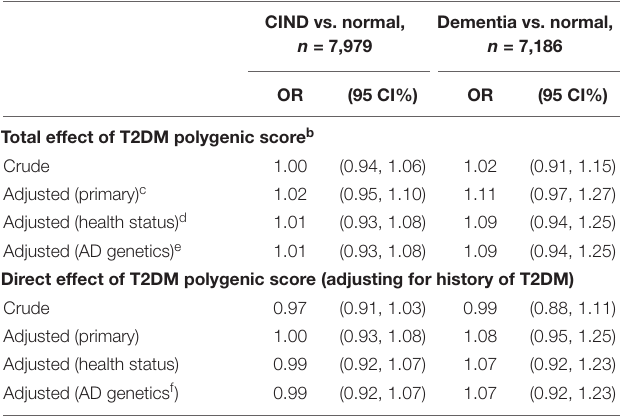
TABLE 3 | Associations between polygenic score for Type 2 diabetes mellitus and cognitive status, Health and Retirement Study, Wave 2010, European ancestry sample ( n = 8,433) a